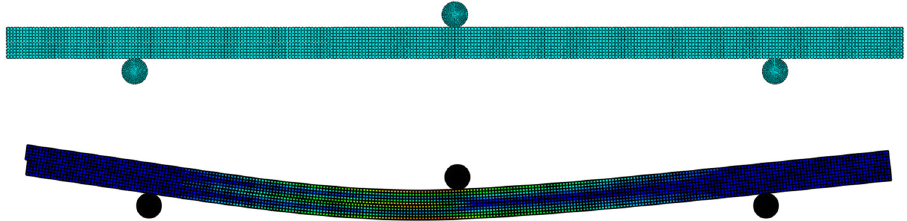
Figure 5: Two - dimensional simulated ENF specimen in ABAQUS